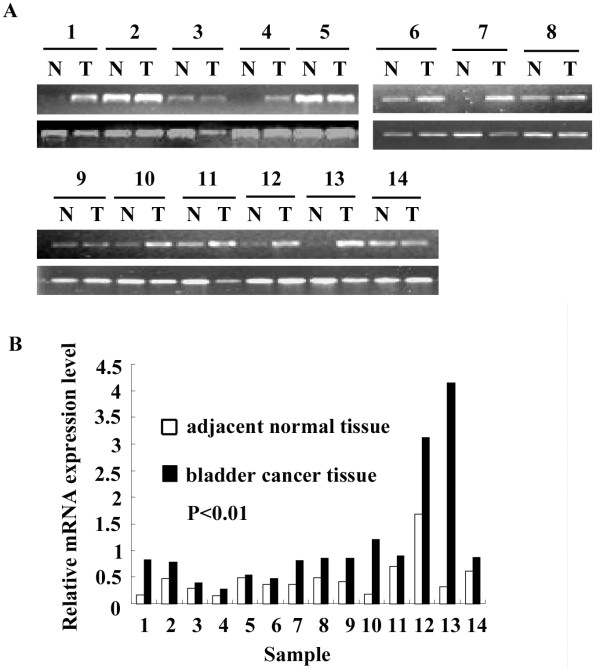
Expression of Bmi-1 mRNA in paired bladder cancers and the adjacent normal tissues by RT-PCR analysis. A: RT-PCR analysis in 14 paired bladder cancers and the adjacent normal tissues (upper panel); β-actin as the internal control (showed in lower panel). B: The relative expression level of Bmi-1 in comparison to the expression level of β-actin.